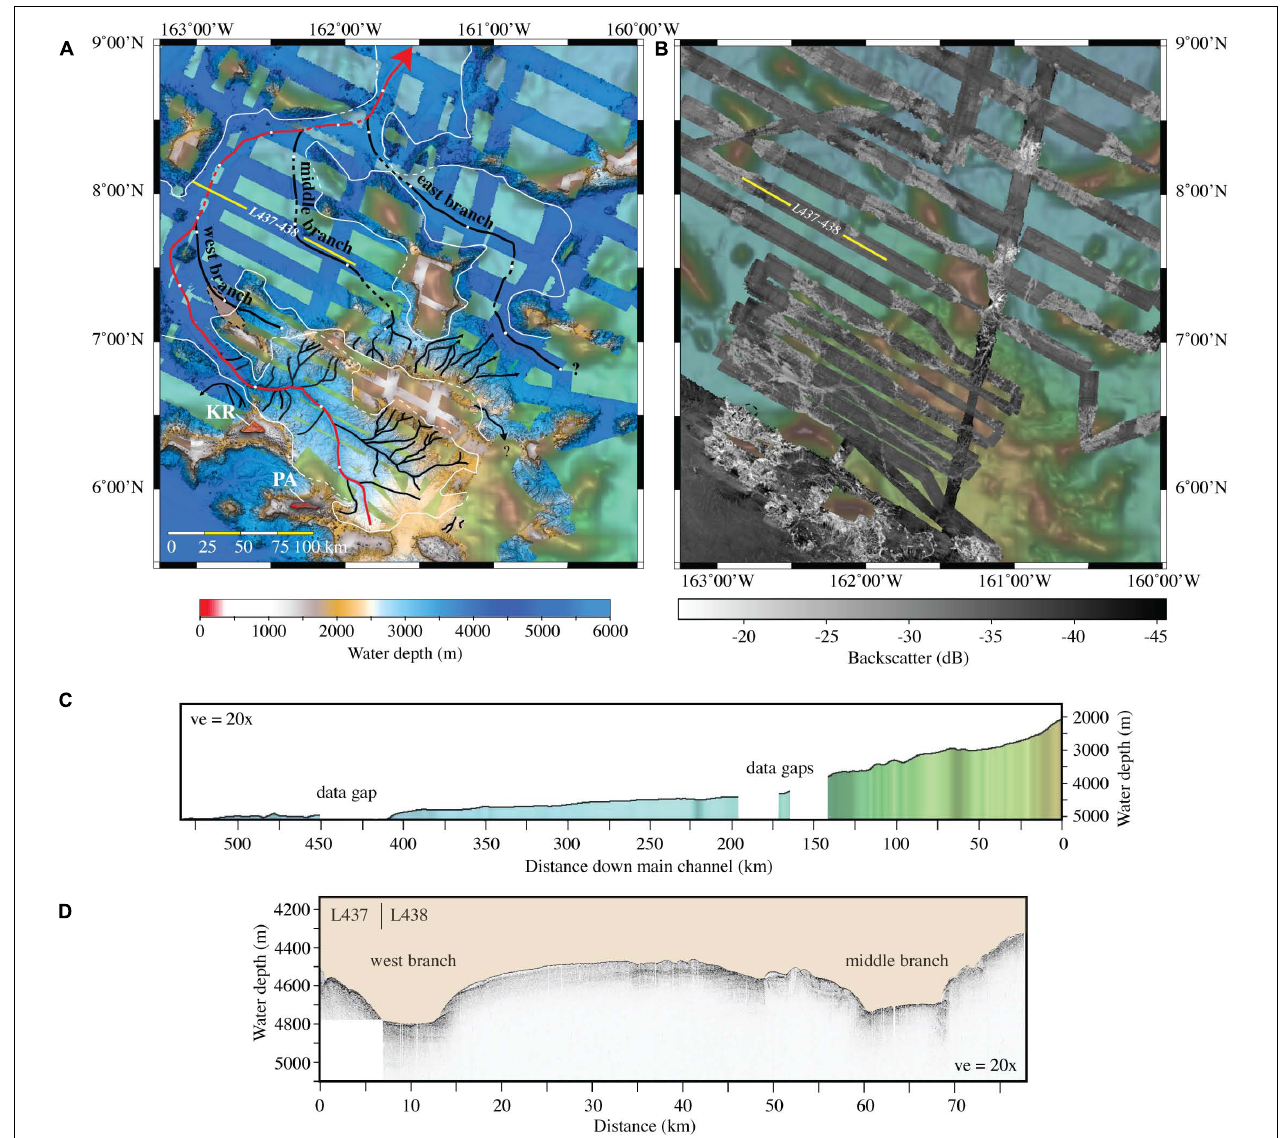
FIGURE 4 | (A) Map view of multibeam bathymetry of channel system CS-A (see Supplementary Figure S3 for same view with no interpretations). Location of CS-A shown on Figure 3 . Drainage area (see text) outlined in white, dashed line is interpreted continuation of channels in areas with no MBES coverage. Main channel is identified in red and tributary channels in black. White circles along main channel and three main branch channels are 50-km down-channel markers. Yellow line is location of subbottom seismic profile L437–438 (see Figure 4D ). Locations shown of Kingman Reef (KR) and Palmyra Atoll (PA). (B) Map view of multibeam backscatter of channel system CS-A. (C) Down-channel profile along the main channel reach. (D) Subbottom seismic profile of L437 and 438 that crosses west and middle branches.